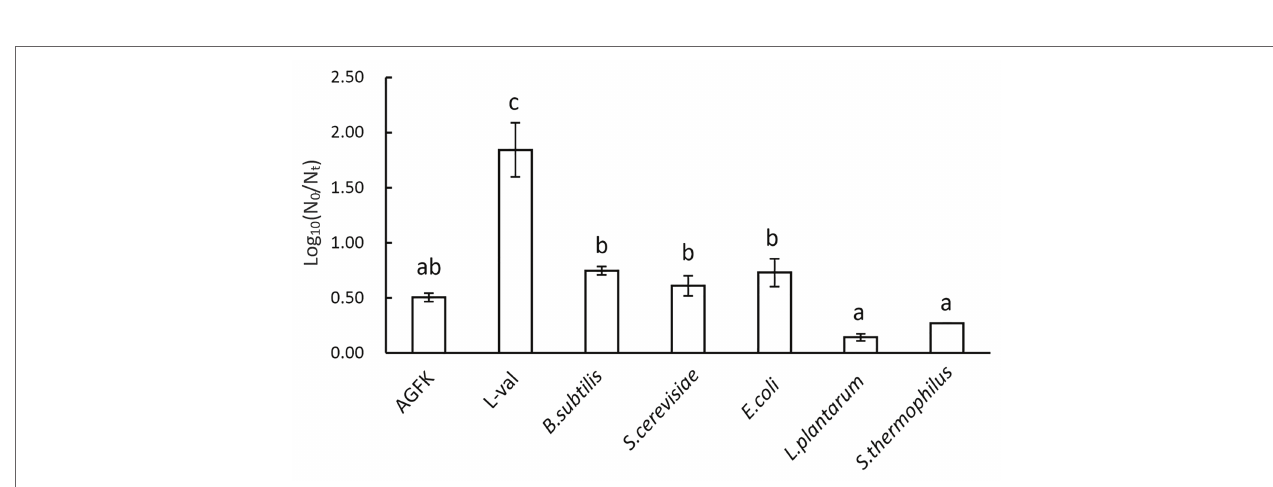
FIGURE 4 | The germination rate of B. subtilis 168 spores with various nutrient germinants or microbial